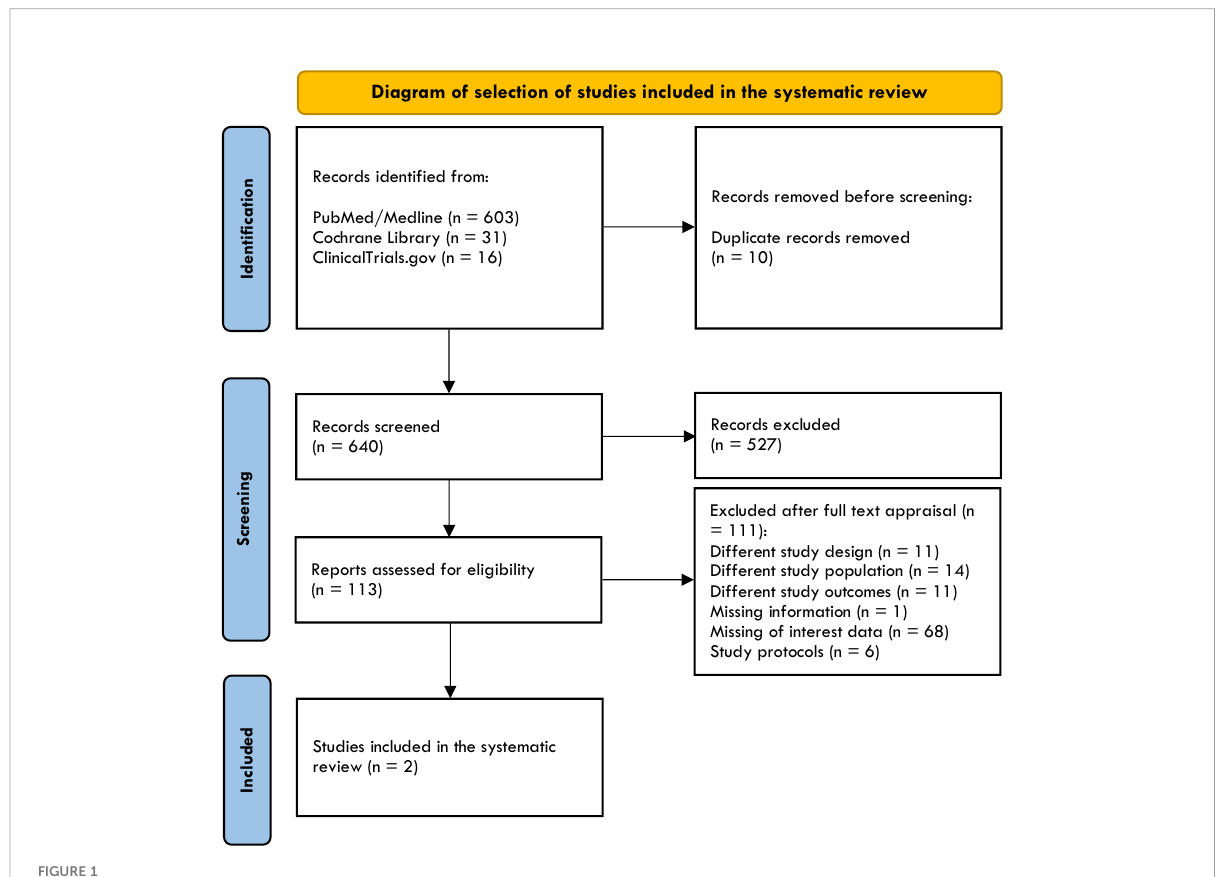
FIGURE 1 Diagram of selection of included